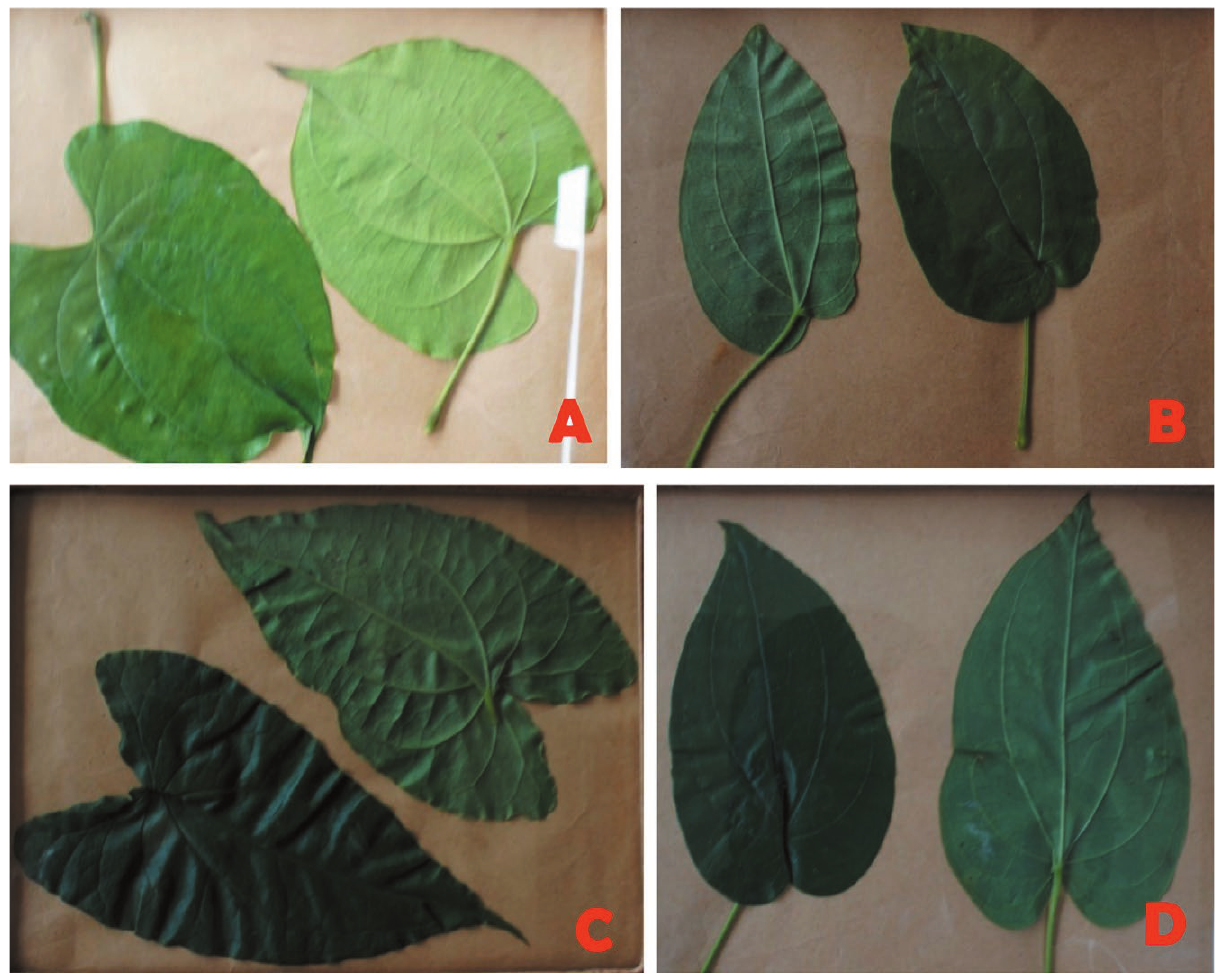
Figure 1. Leaf form and shape in some the cultivars of Dioscorea studied. (a) D. cayenensis (b) D. rotundata (c) D. rotundata (d) D. rotun-